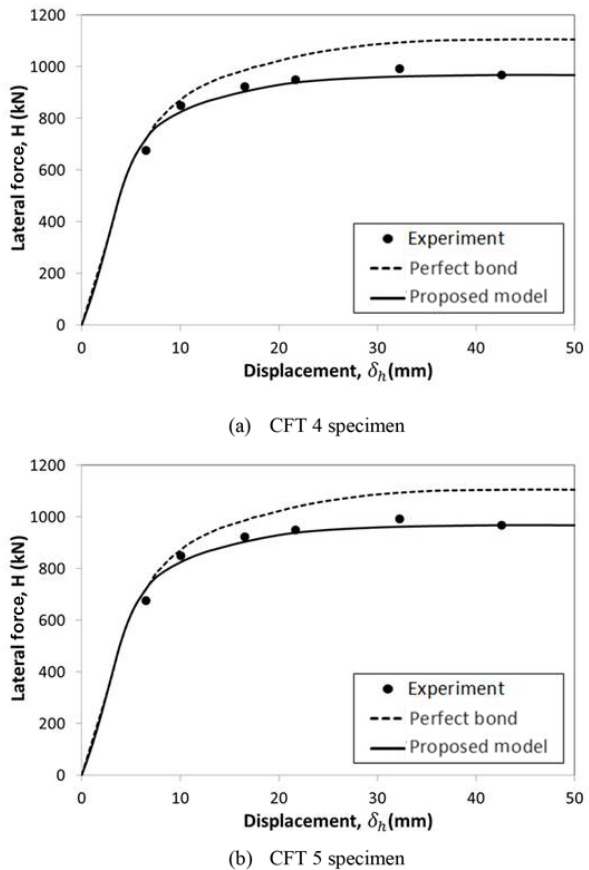
Figure 12. Lateral force-displacement relation under axial force and bending moment.